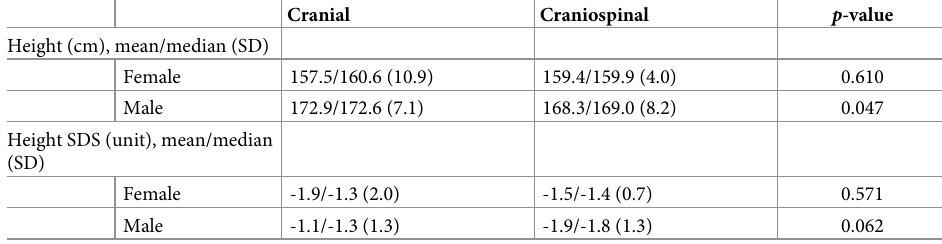
Table 5. Height and height SDS of the subjects by irradiation